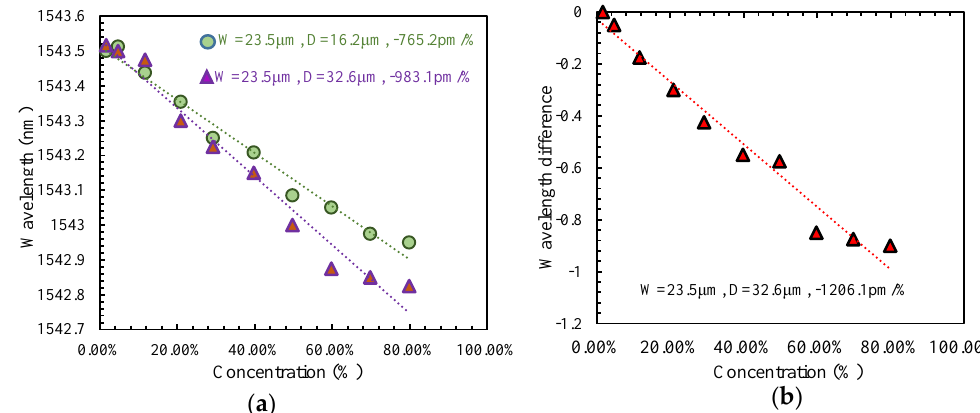
Figure 6. Linear fittings between dip wavelength and alcohol concentration of ( a ) two sensors with different cavity diameter, respectively. ( b ) Linear fitting between dip wavelength difference and alcohol concentration of graphene-filled sensor.